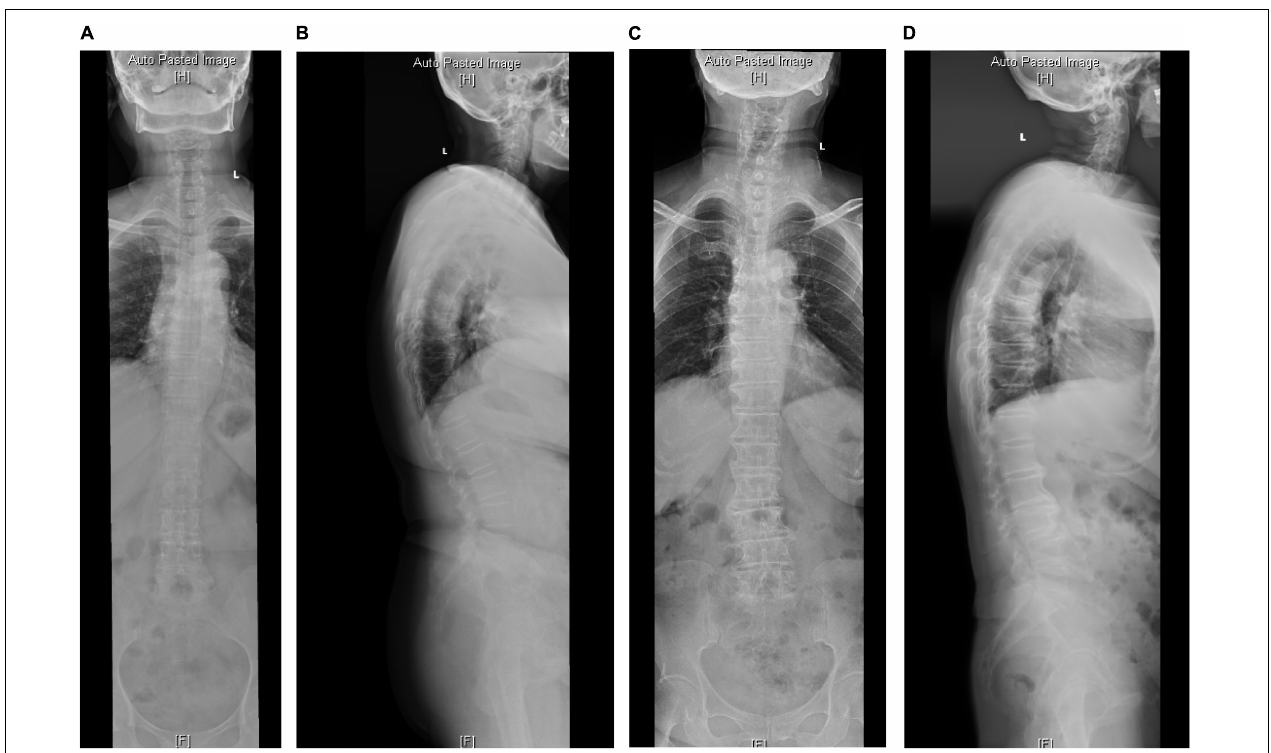
FIGURE 1 | The radiological parameters measured on standard anterior-posterior and lateral whole spine X-ray of cases from the SB group. (A,B) In a 70-year-old man, TK = 58, TLK = 26.1, LL = 56.1, PI = 51, PT = 20.4. (C,D) In a 68-year-old woman, TK = 29.4, TLK = 15.2, LL = 35.3, PI = 44.7, PT =